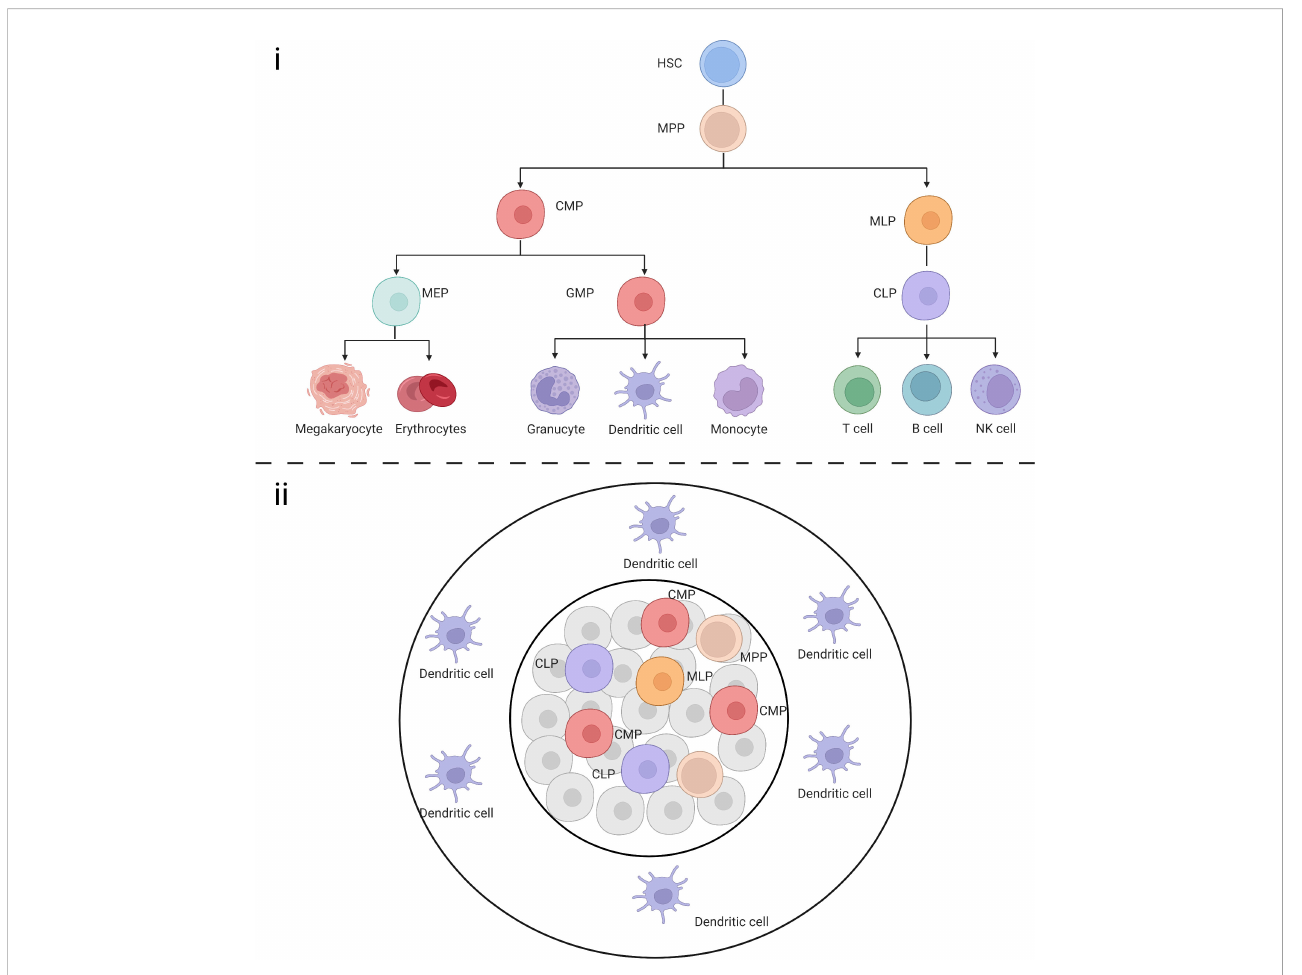
FIGURE 3 (i) Schematic representation of classical HSCs in a tree-like model. (ii) Multiple progenitor cells maintain the ability to differentiate into